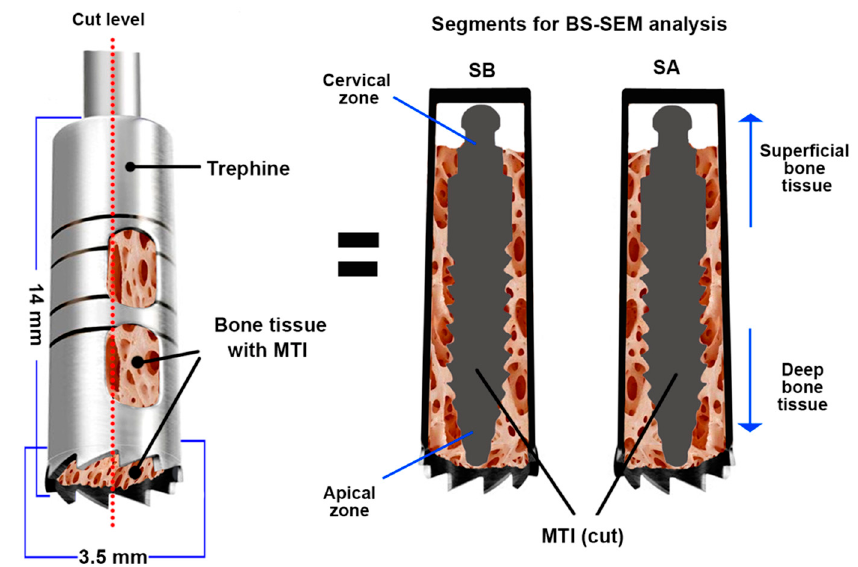
Figure 1. Bone sample with mini transitional implants (MTIs) obtained by trephine. A cut was made to obtain two samples (SA and SB) for backscattered scanning electron microscopy (BS-SEM) analysis. MTI = mini transitional implant; SA and SB = Segments A and B obtained after the